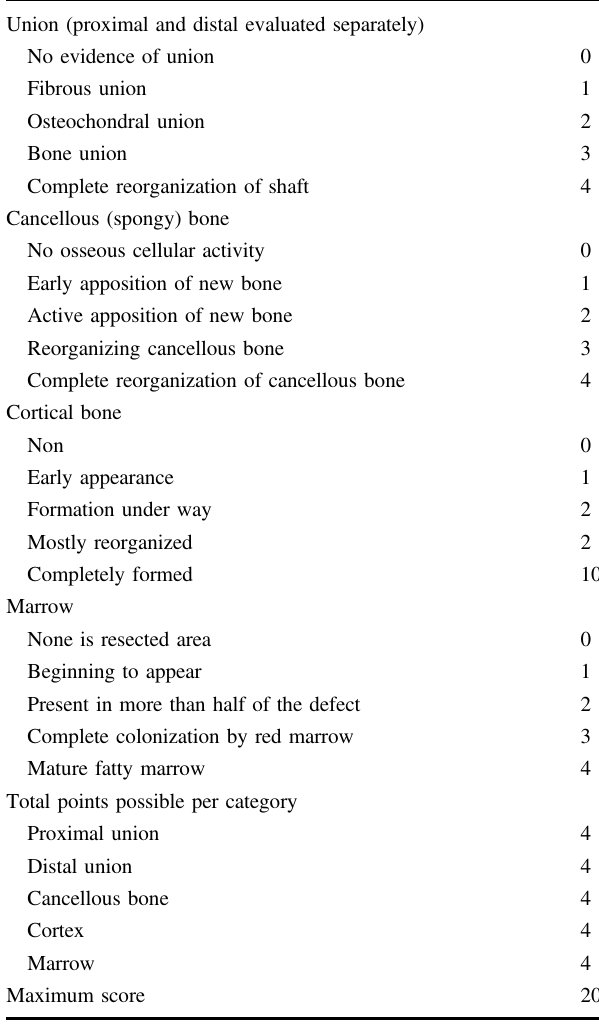
Table 2 Lane and Sandhu histopathological scoring system modi fi ed by Heiple et al.